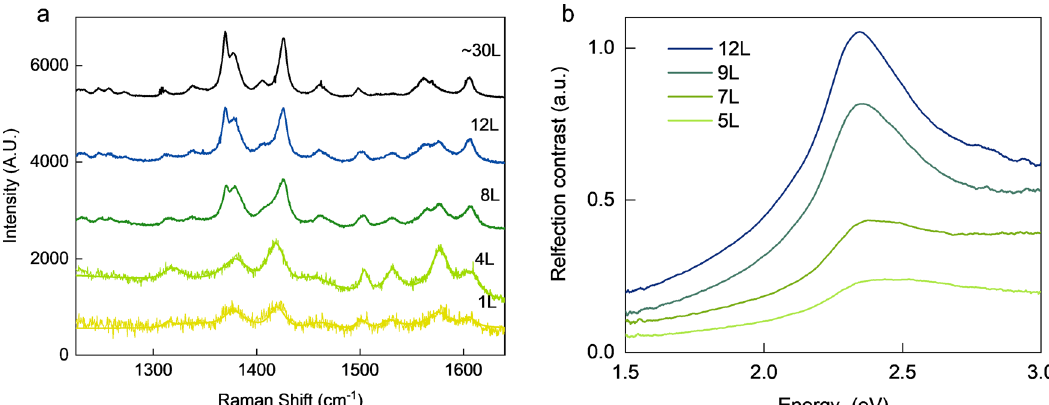
Fig. 2 Raman and re fl ection contrast spectroscopies of exfoliated FTBQS samples. a Raman spectra as a function of the layer number of samples. 532 nm laser was used as the excitation source. The plotted region has the strongest Raman signal. The Raman spectrum down to ~120 cm − 1 is included in Supplementary Fig. 4. b White light re fl ection contrast spectroscopies as a function of the layer number. Samples for this measurement were exfoliated onto transparent, fused silica